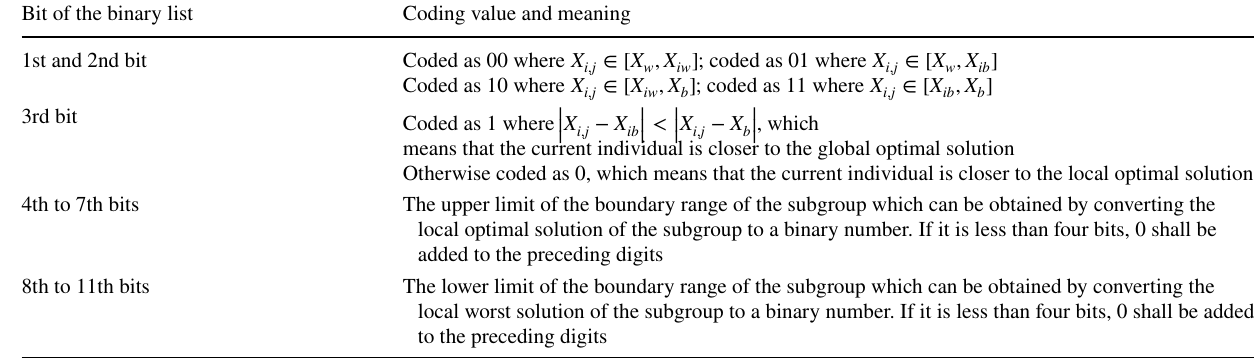
Fig. 1 Schematic diagram of the roulette-based individual selection mechanism Table 1 Genetic coding mechanism based on multi-source information fusion Bit of the binary list